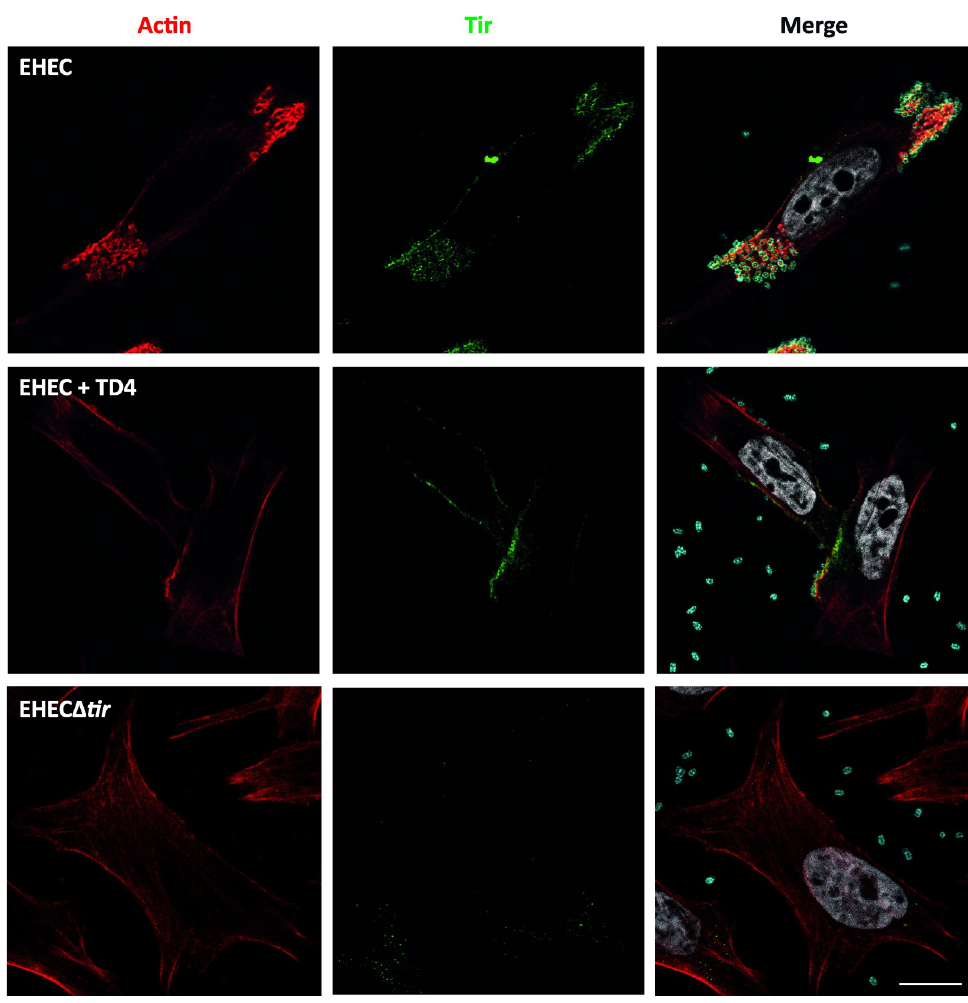
Fig 3. Effect of TD4 after 6 h-long infection of HeLa cells with EHEC. Images of sample slices were taken at the confocal microscope after 6 h of infection. The upper panels show the infection control of wt EHEC; the middle panels, the effect of TD4 (200 nM) to this infection; and the panel in the bottom, the infection of the EHEC Δ tir mutant. Fluorescent-staining of F-actin is shown in red, the O157 antigen of EHEC in cyan, TirM of EHEC in green and DNA in gray. Bar = 7.5 μ